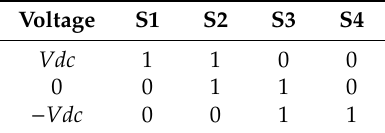
Table 1. 3- Voltage levels of DC-MLI and switching